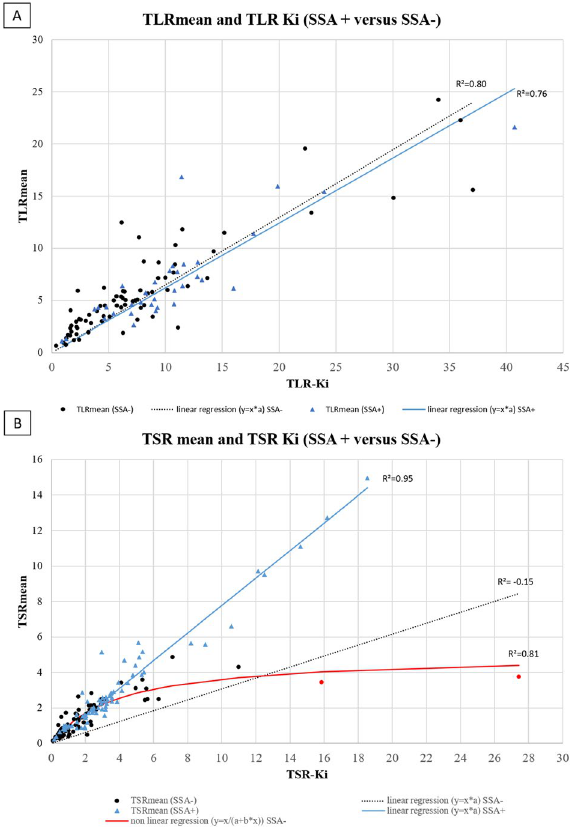
Figure 7. Correlation between TLRmean/TLR-Ki and TSRmean/TSR-Ki according to SSA treatment. *Red circle correspond to the 2 bones lesions of patient